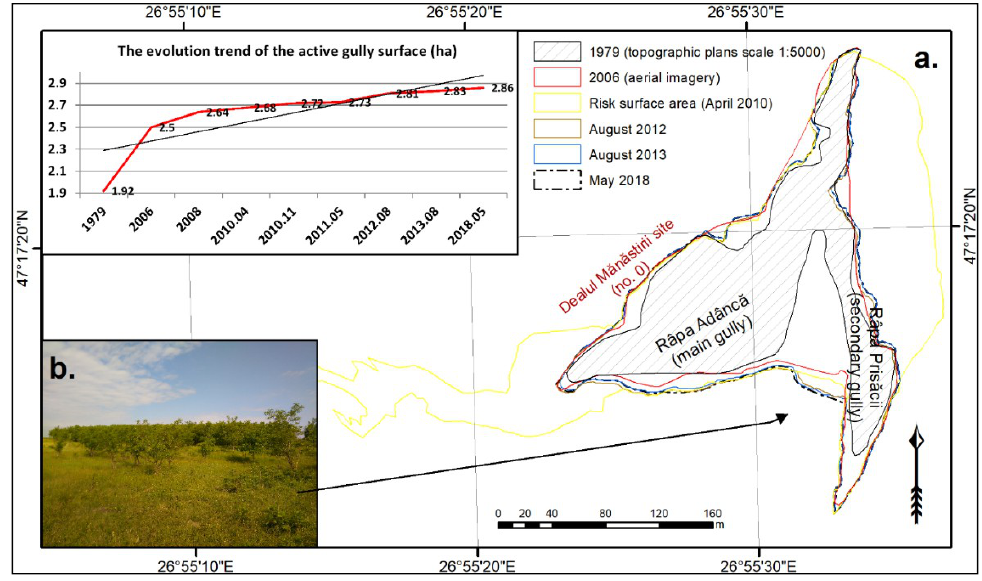
Figure 7. ( a ) Băiceni-Cucuteni gully evolution over the last 39 years, ( b ) the forest developed on the upper part of the gully.